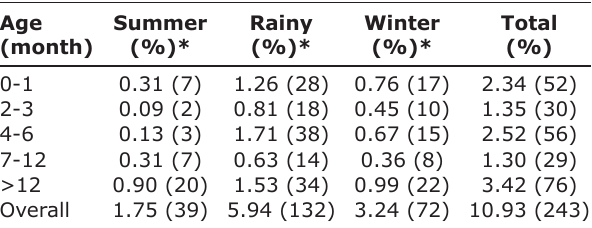
Table-2: Age and season-wise mortality rate in Rohilkhandi local goat. Age Summer Rainy Winter (month) (%)* (%)* (%)*